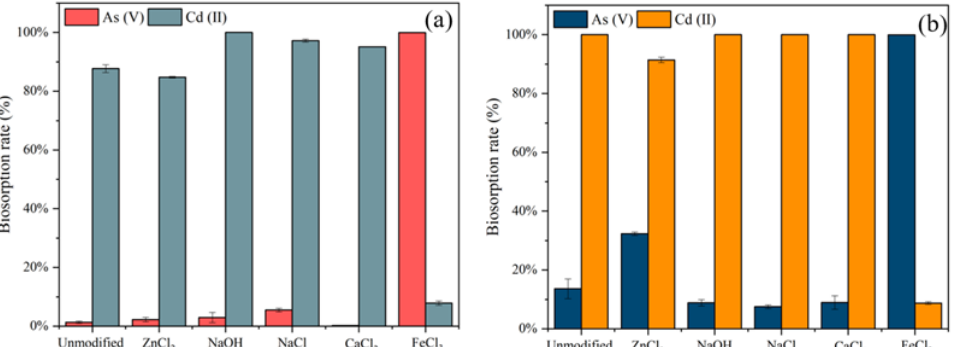
Figure 2. Biosorption rates (%) for As(V) and Cd(II) by ( a ) unmodified and chemically modified C. vulgaris , and ( b ) unmodified and chemically modified S. platensis.